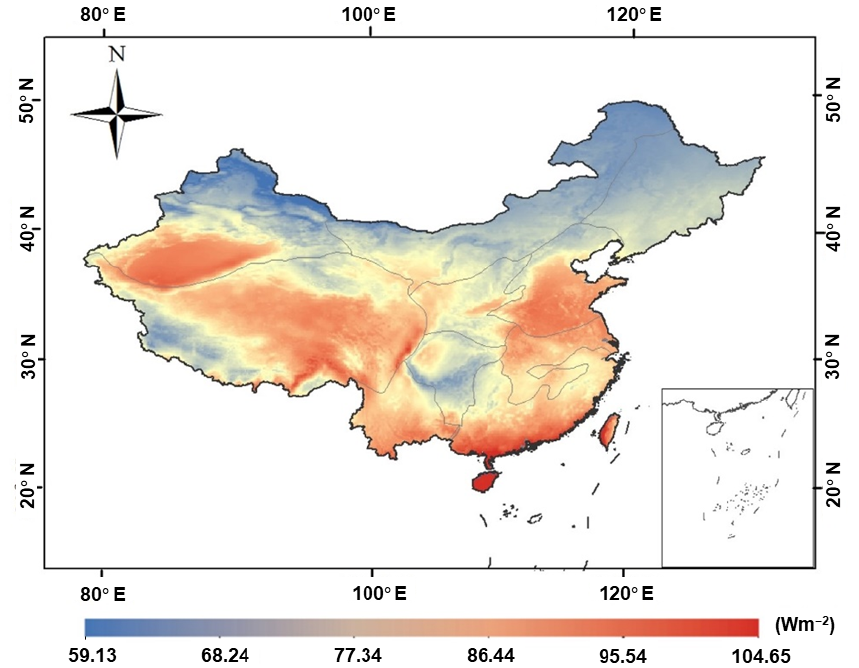
Figure 10. Validation of surface diffuse solar radiation products under different aerosol concentra- tions conditions.